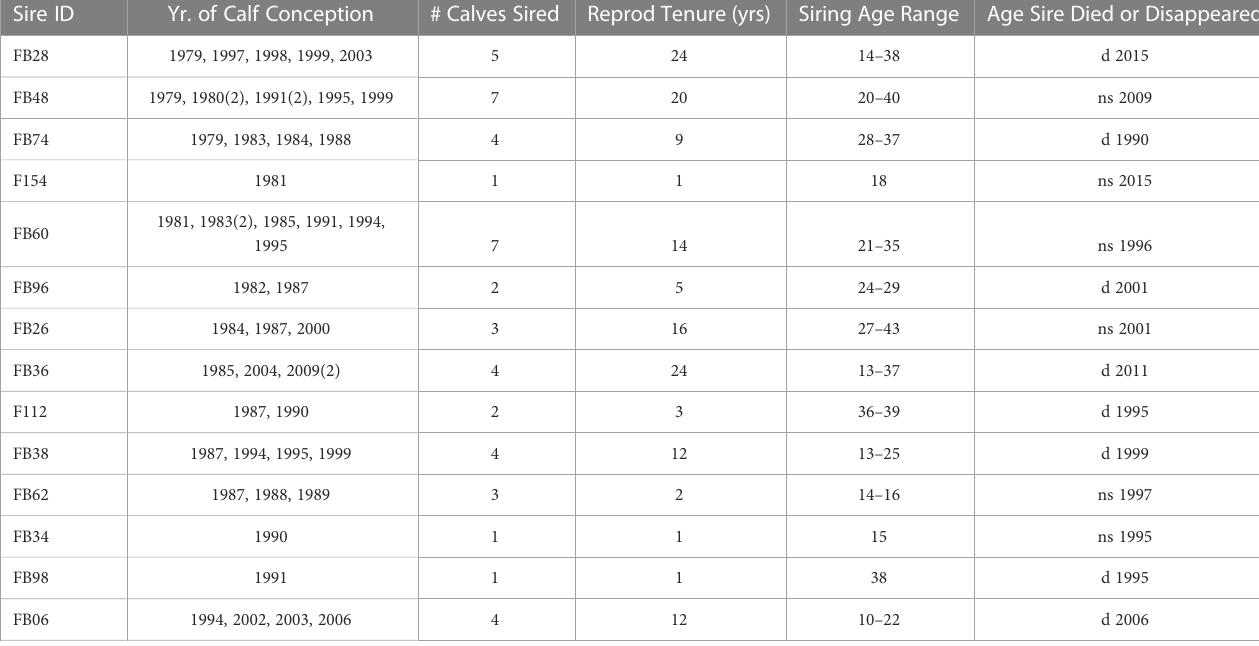
TABLE 2 Reproductive history for the males assigned to speci fi c calves. Sire ID Yr. of Calf